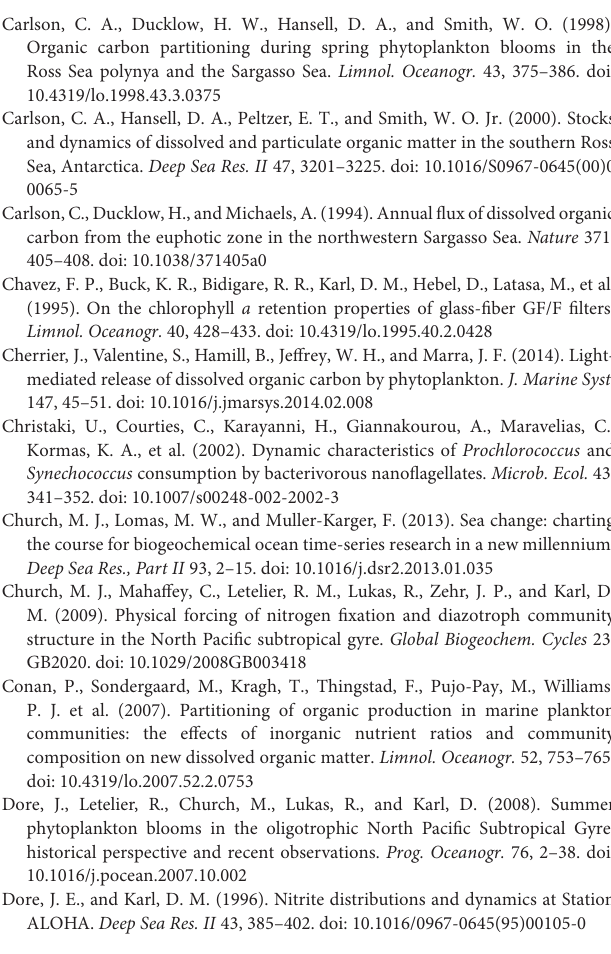
Supplementary Figure 1 | Results from experiments comparing retention of 14 C organic matter onto either glass fiber or polycarbonate membrane filters. (A) 14 C-labeled primary production samples filtered either onto glass fiber filters alone, polycarbonate filters alone, glass fiber filters placed on top of polycarbonate filters (GFF/PC), or polycarbonate filters placed on top of glass fiber filters (PC/GFF); (B) chlorophyll a samples filtered across the same configuration of filters. (C) Sequential 100ml re-filtrations of 14 C-PC filtrate onto successive new glass fiber filters (in triplicate). (D) Comparison of average (from triplicates) 14 C-DOC adsorbed to glass fiber filters from initial 100ml filtration, sum of all five 100ml re-filtrations (for a total volume of 500ml, 100ml per filter) onto five separate filters, and filtration of 500ml onto single glass fiber filters. Supplementary Figure 2 | Differences between 14 C-activity on glass fiber and polycarbonate filters ( 14 C-delta = 14 C-GFF - 14 C-PC) where different volumes of seawater were filtered. 14 C-delta derived from paired samples where 100ml of seawater was filtered onto polycarbonate filters, while varying volumes (100, 150, 400, and 500ml) of seawater were filtered onto glass fiber filters. Midline of box plots indicates median value, while the upper and lower borders of the box represent the 75th and 25th percentiles,